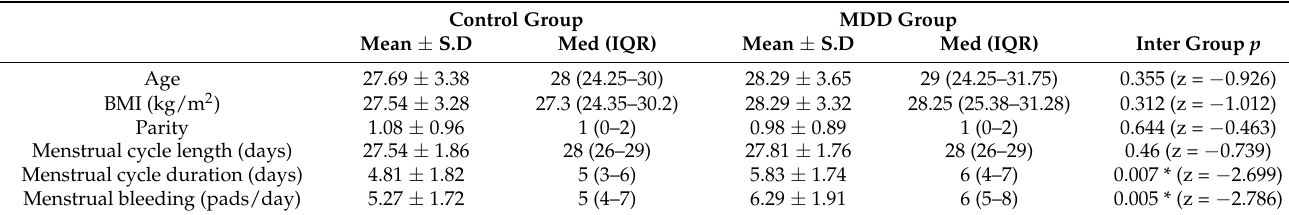
Table 1. Differences in demographic characteristics according to the study